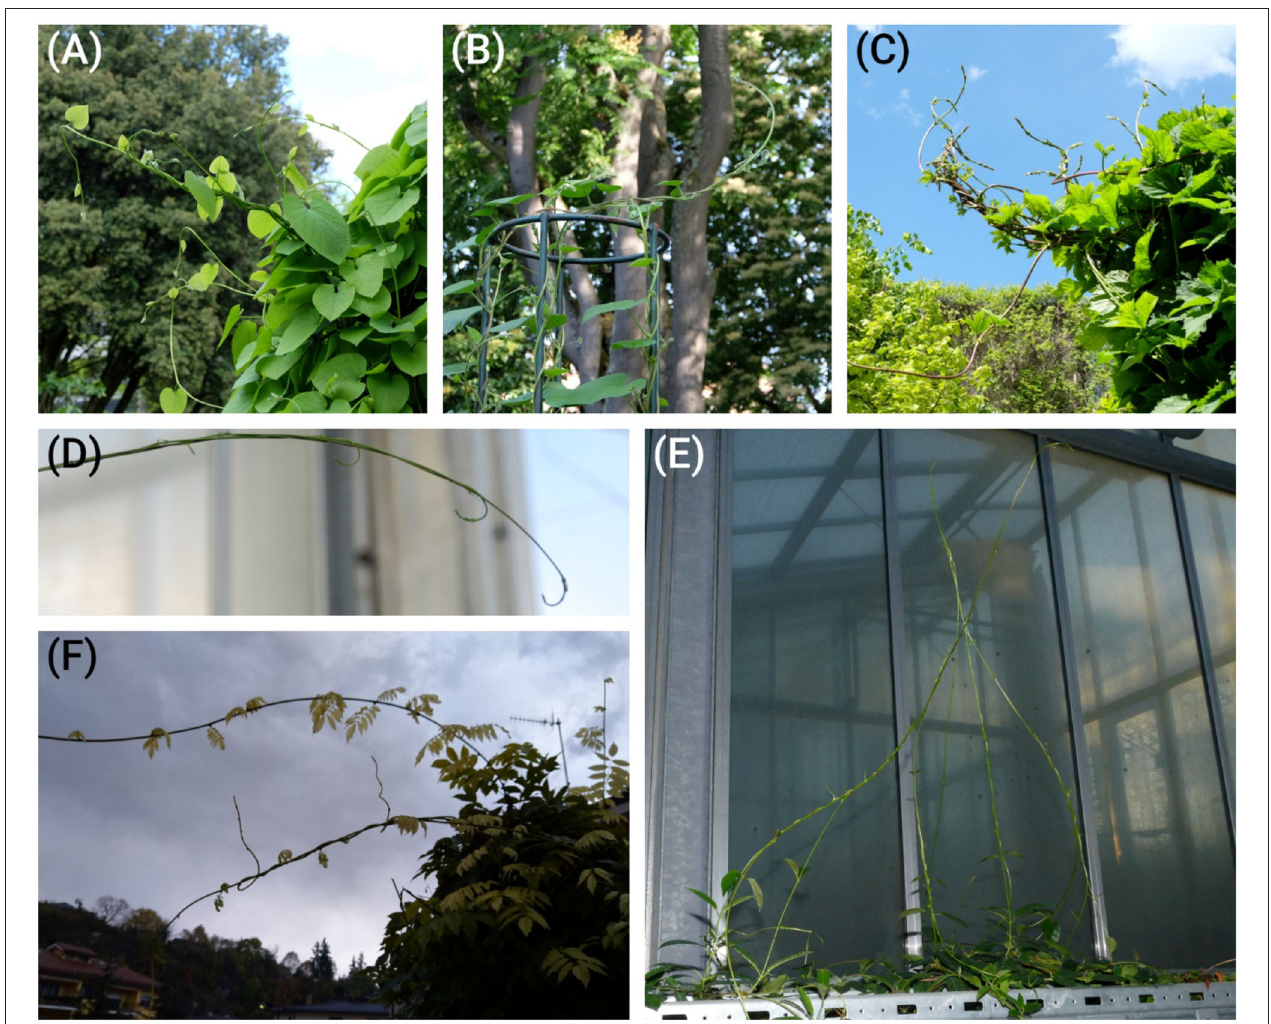
FIGURE 4 | Plants with searcher stems that are intertwining and providing mutual support. Aristolochia macrophylla (A) , Ipomoea tricolor (B) , Humulus lupulus (C) , Dipladenia sp. (D–E) , and Wisteria sp. (F) .